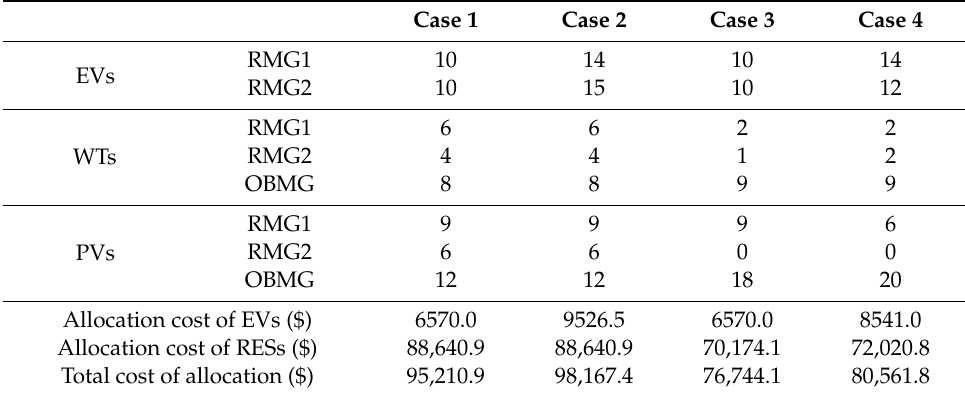
Table 1. Comparison of Allocations in all Four Cases.